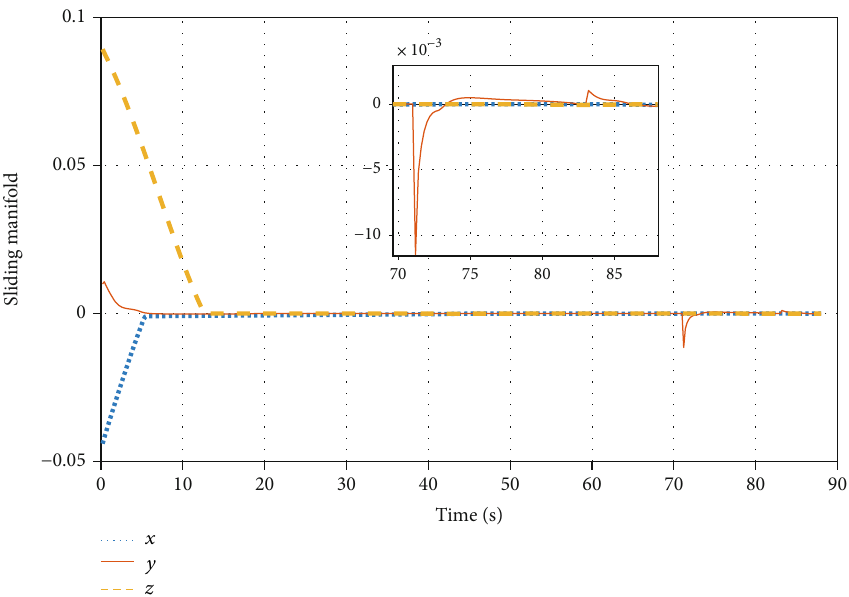
Figure 18: Components of the sliding